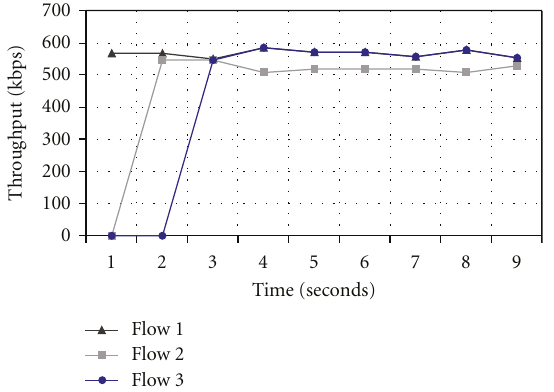
Figure 2: Throughput of three flows (1, 2, 3) versus time. RTS/CTS mechanism is enabled.